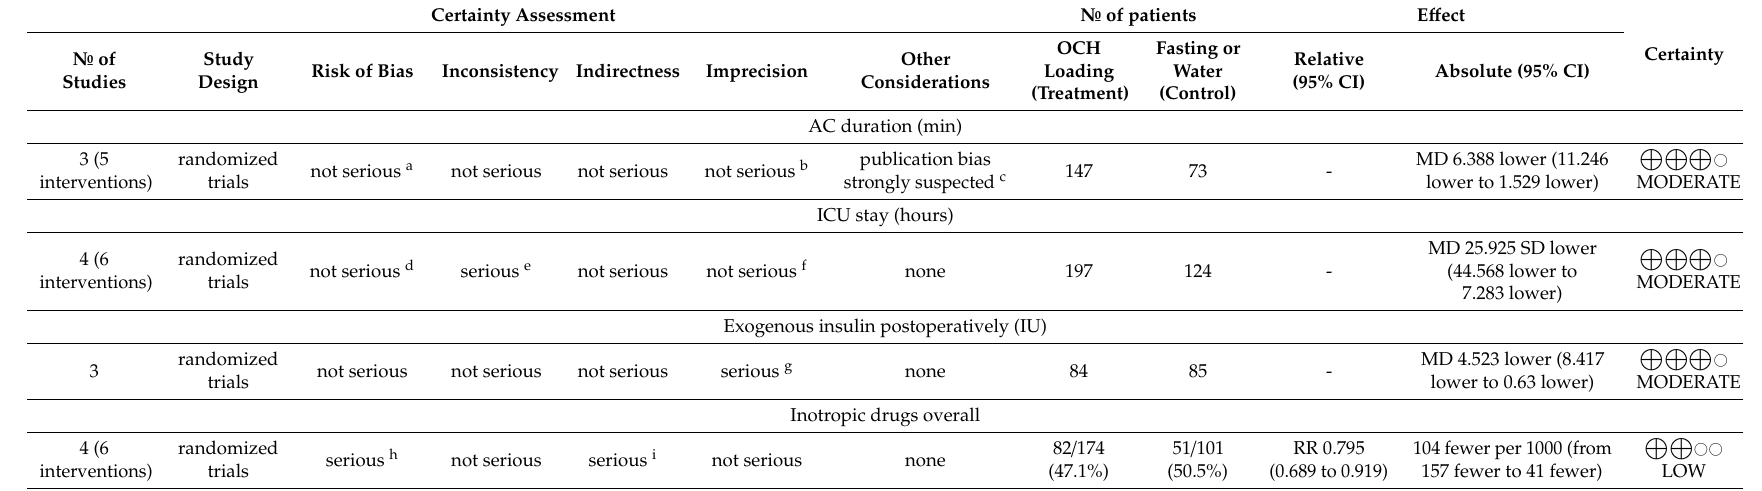
Table 4. GRADE (Grading of Recommendations, Assessment, Development and Evaluation) analysis: quality assessment of evidence. Certainty